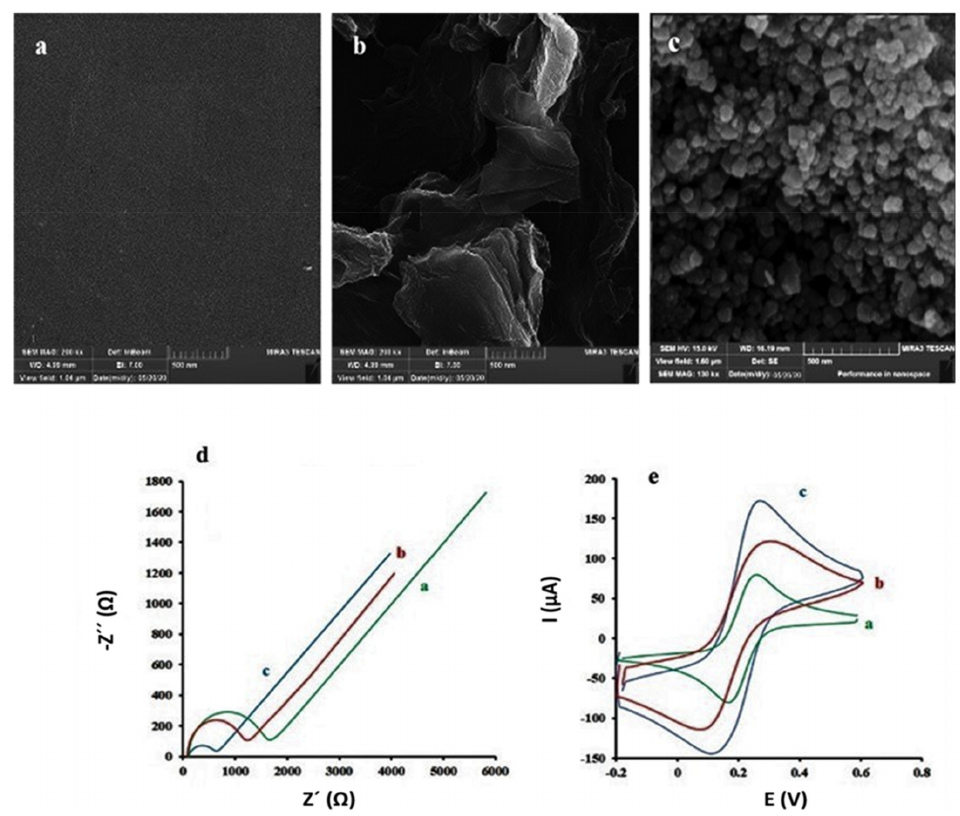
Figure 7. SEM micrographs of neat GCE ( a ), rGO/GCE ( b ), and rGO/GCE/Fe 3 O 4- PPy ( c ). Nyquist plots ( d ) and CV ( e ) of neat GC (a), rGO/GC (b) and rGO/GCE/Fe 3 O 4- PPy (c). Taken from [70], copyright 2021,